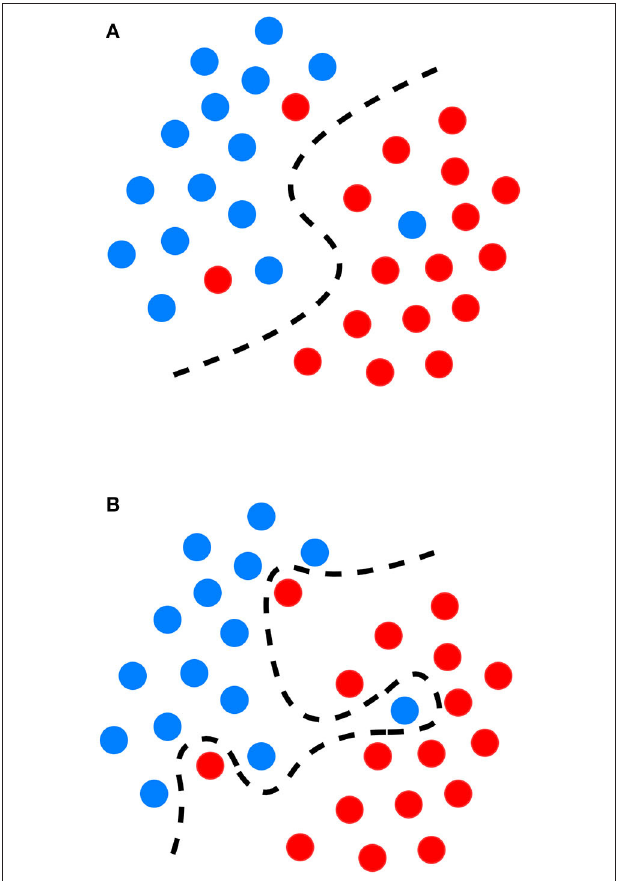
FIGURE 1 | Graphical representation of the decision boundary (red line) in an optimal fitting (A) and overfitting model (B) overfitting describes a state of model which has poor generalizability due to excessive fitting of noise data presented in a training